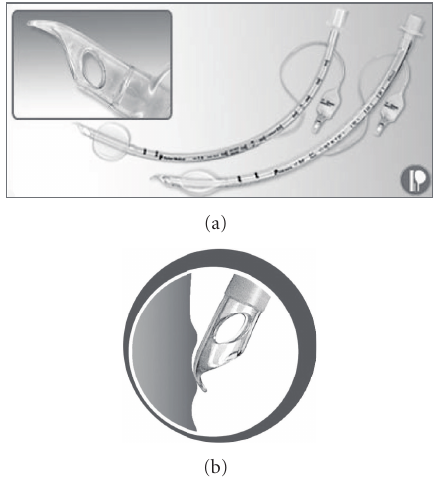
Figure 3: Impingement is less likely with taper-tipped tubes.